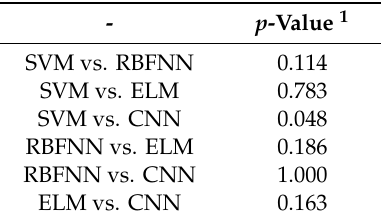
1 The parameters of the SVM model were the penalty coe ffi cient ( C ) and kernel function parameter ( γ ); the parameter of the RBFNN model is the spread value; the parameter of the ELM model was the number of nodes in the hidden layer; the parameters of CNN can be found in Table 1. Table 3. Chi-square test for the prediction results of support vector machine (SVM), radial basis function neural network (RBFNN), extreme learning machine (ELM), and convolutional neural network (CNN) models on the full